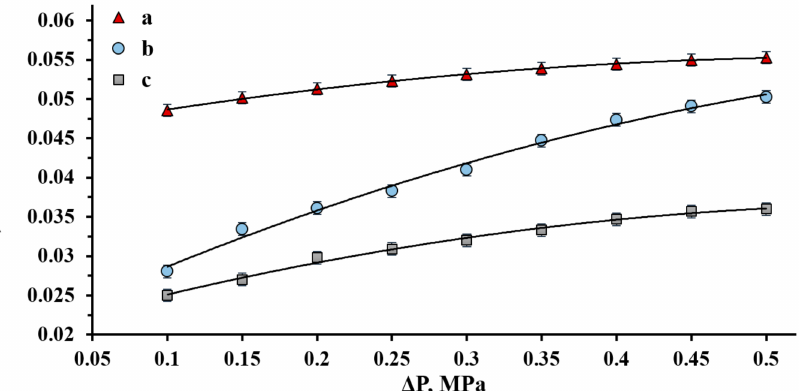
Figure 5. Gauge pressure dependence of the hydrogen flux at t = 300 ◦ C on the inlet side of the PdCu–Nb–PdCu membrane modified with a nanostructured coating (a) and non-modified membrane (b) and a regular Pd membrane